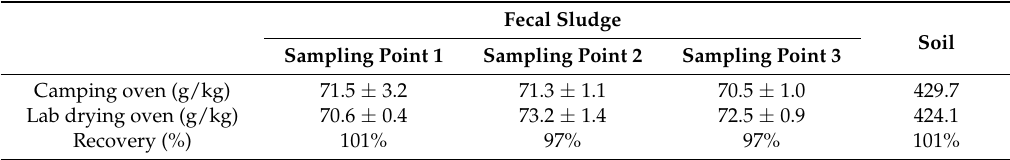
Table 3. Modification of the Total Solids (TS) method; comparison of camping baking oven and electrical oven.